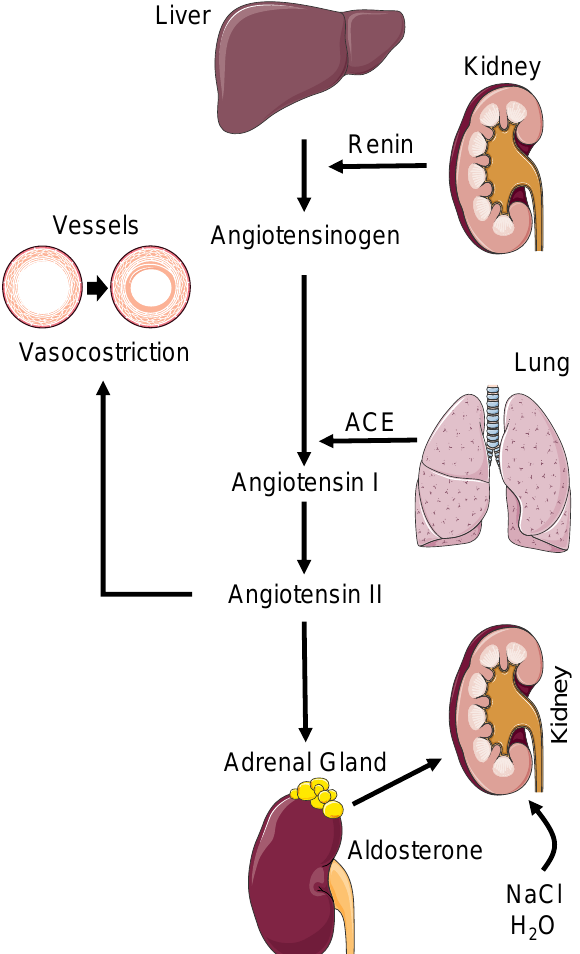
Figure 1. Schematic representation of the renin-angiotensin-aldosterone system. ACE: Angiotensin Converting Enzyme, H 2 O: chemical formula for water, NaCl: chemical formula for sodium chloride. See text for details.